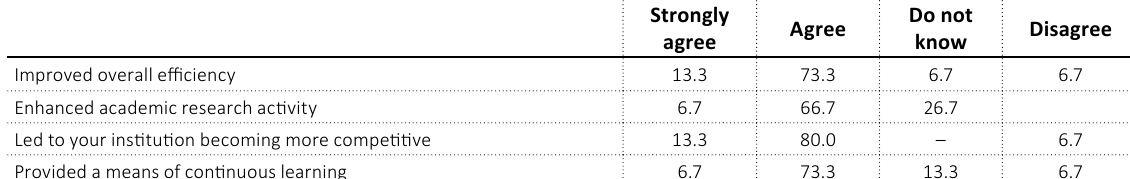
Table 4. Knowledge management practice and KMIS improves efficiency, competitiveness and continuous